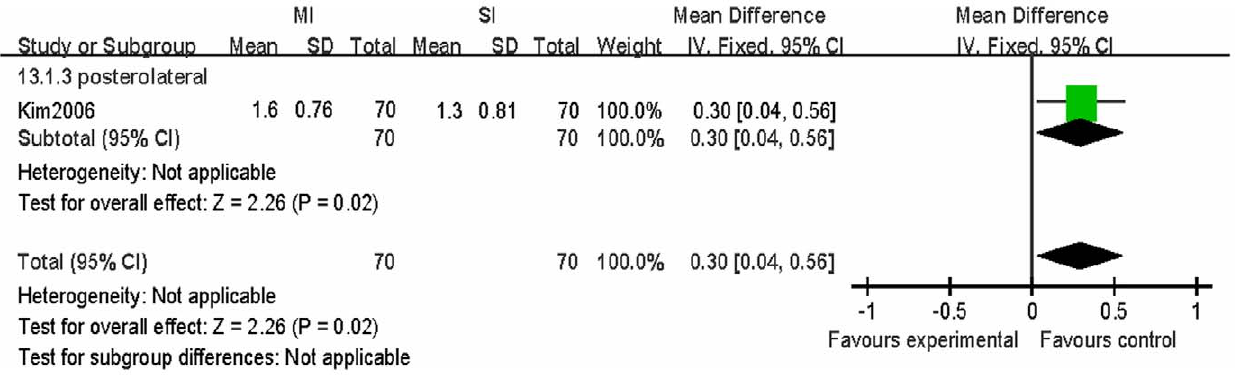
Figure 4. Forest plot of the differences in the increase of post-operative femoral offset in the MITHA and TTHA groups. The MITHA groups had significantly increased femoral offset than the TTHA groups